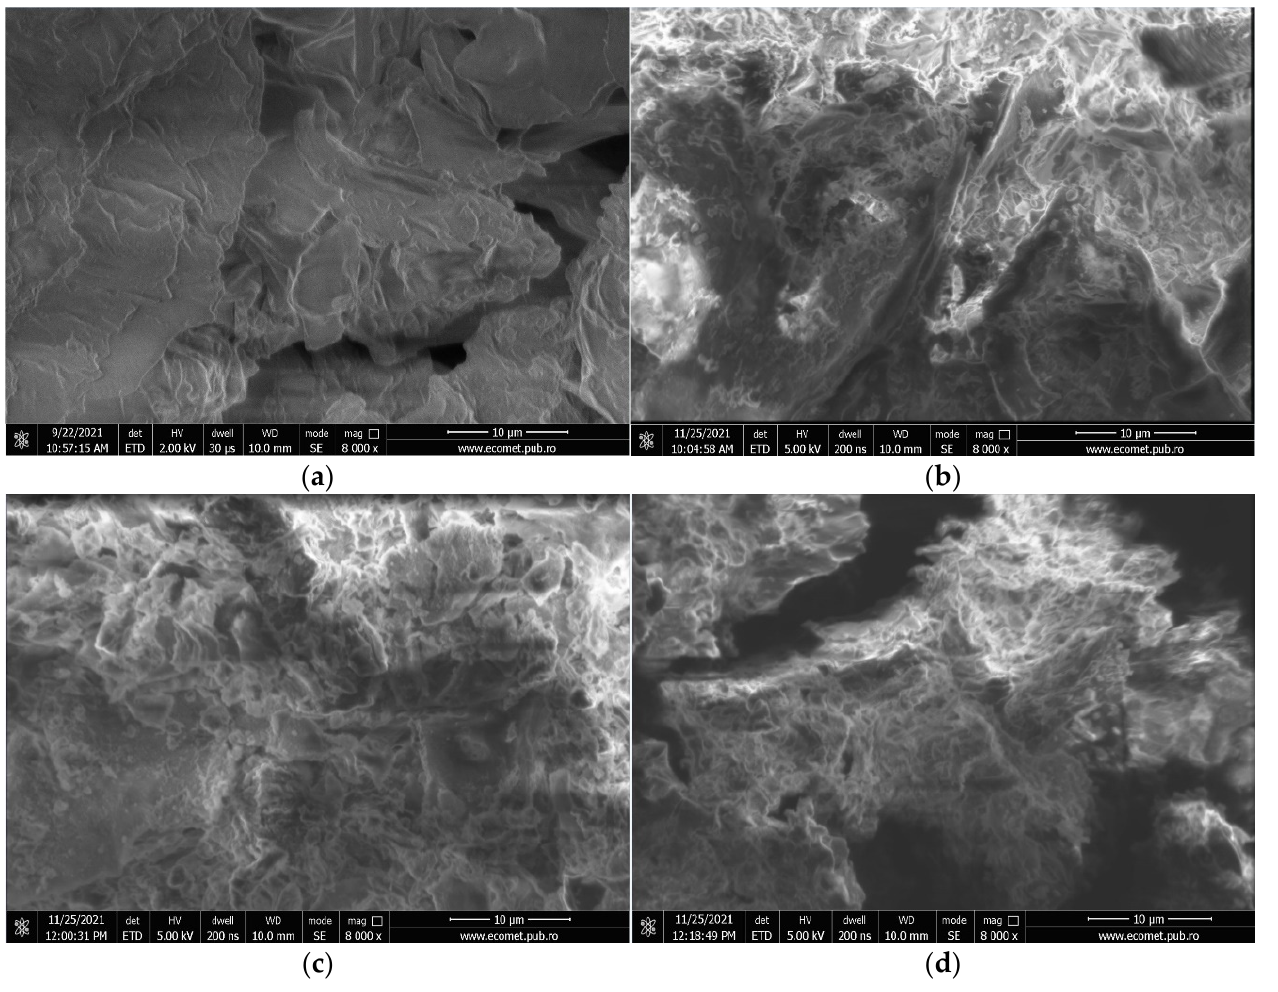
Figure 2. SEM images for WS ( a ) and hydrothermal char from walnut shells: HCWS1 ( b ), HCWS2 ( c ), and HCWS3, respectively ( d ), magnification 8000×, scale 10 μ m.